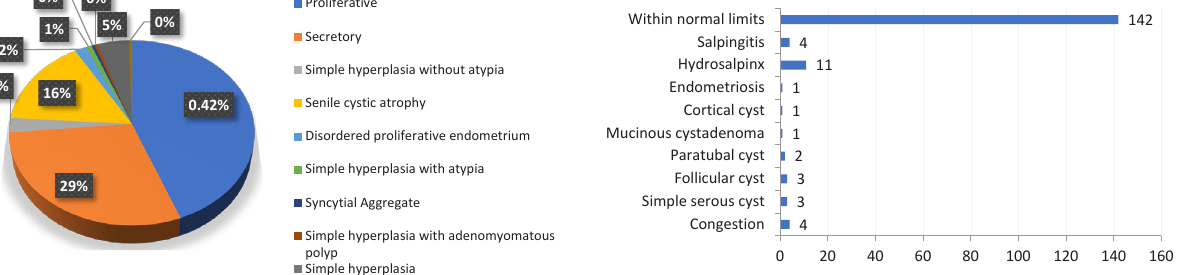
Figure 1. Histopathological Findings in the Endometrium